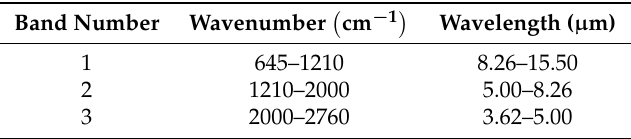
Table 2. Definition of IASI